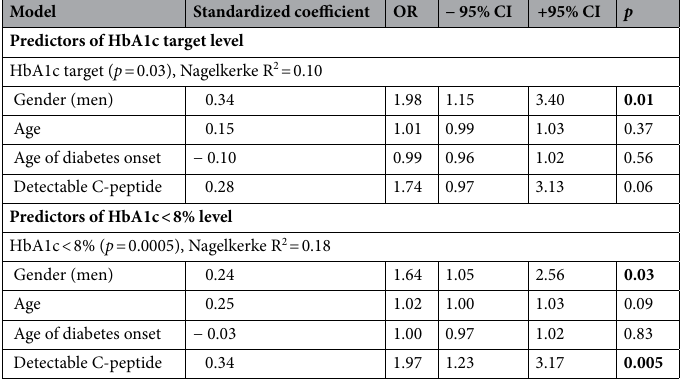
Table 2. Predictors of HbA1c target level (logistic regression) and of HbA1c < 8% level (logistic regression). Data shown: Odds ratio (OR), 95% confidence intervals (CI) and p -value (p<0.05 in bold).